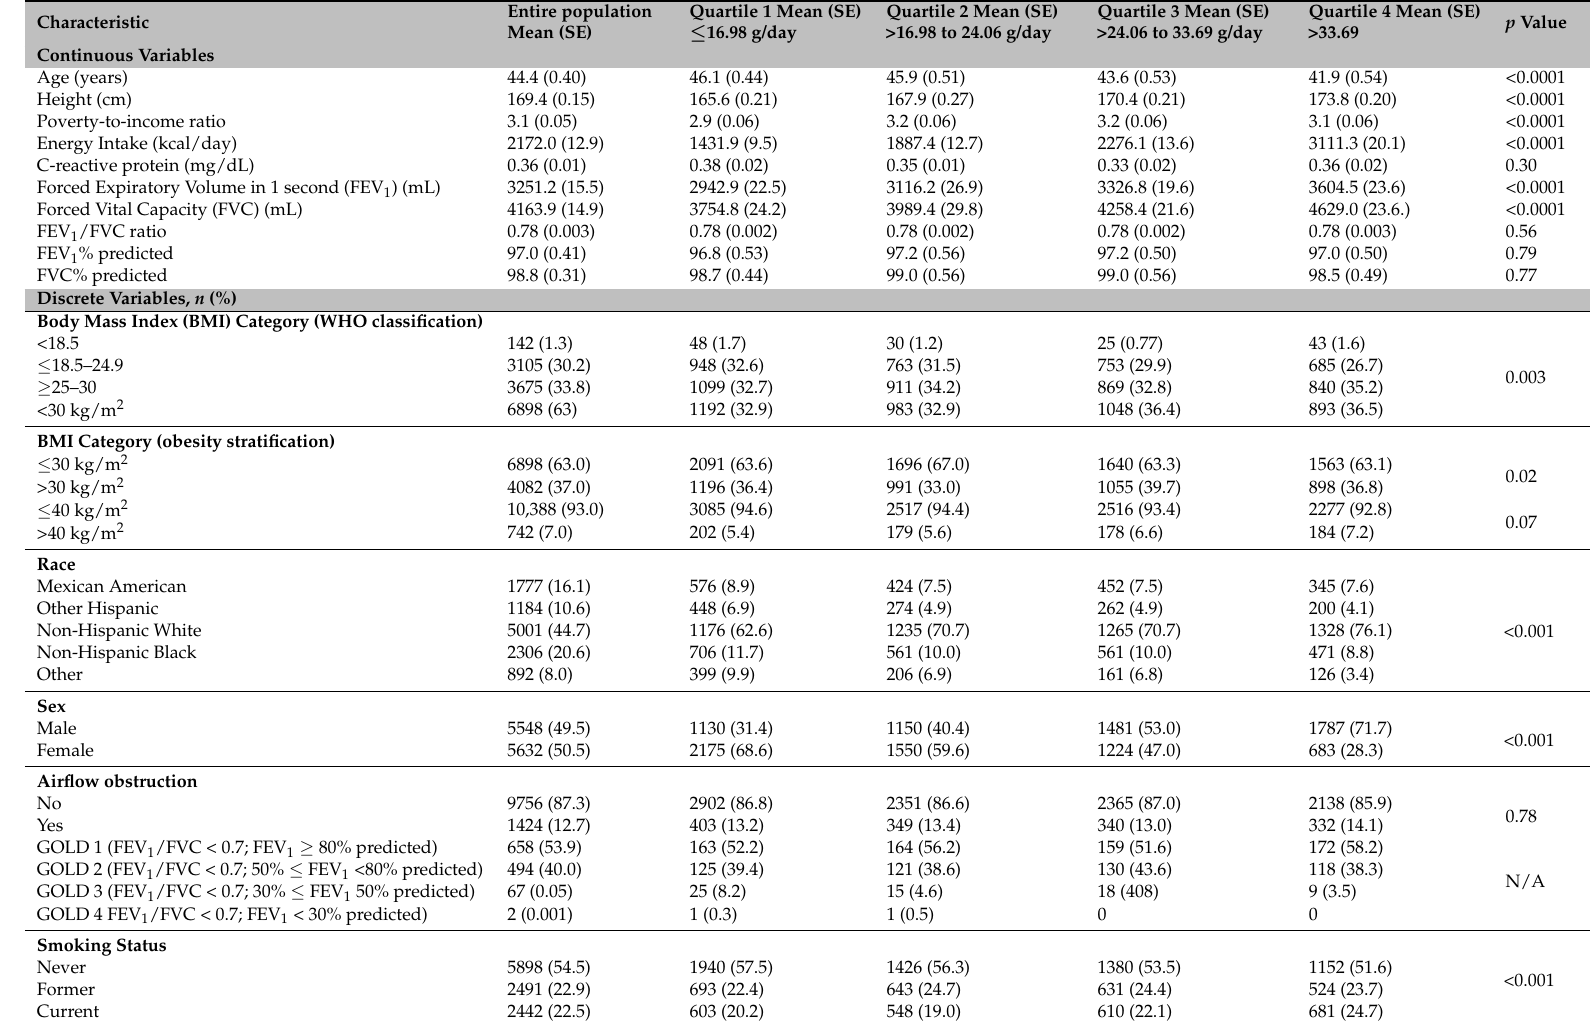
Table 1. Participant characteristics stratified by the total saturated fat intake quartiles ( n =